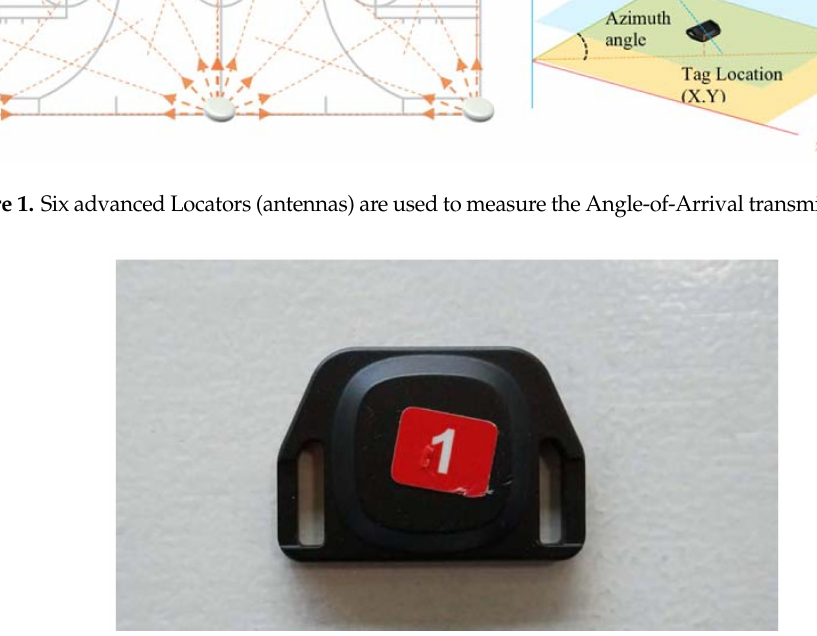
Figure 2. Tags use Bluetooth Low Energy to send a radio signal to a positioning engine, which uses proprietary algorithms to calculate the tag position (44 × 31 × 8 mm, 10